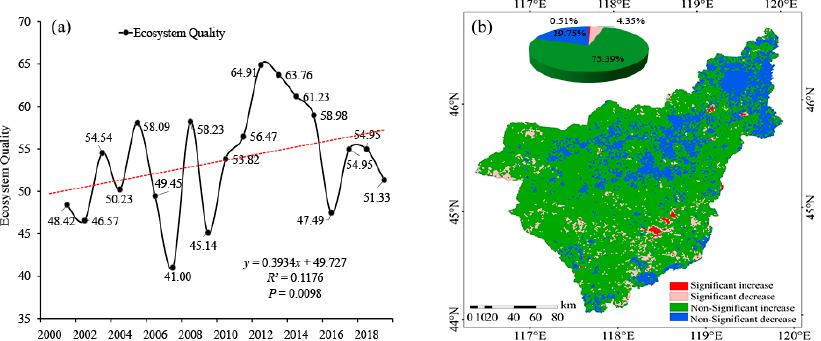
Figure 7. Interannual trends ( a ) and spatial distribution ( b ) of ecological quality in the URB from 2001 to 2019.